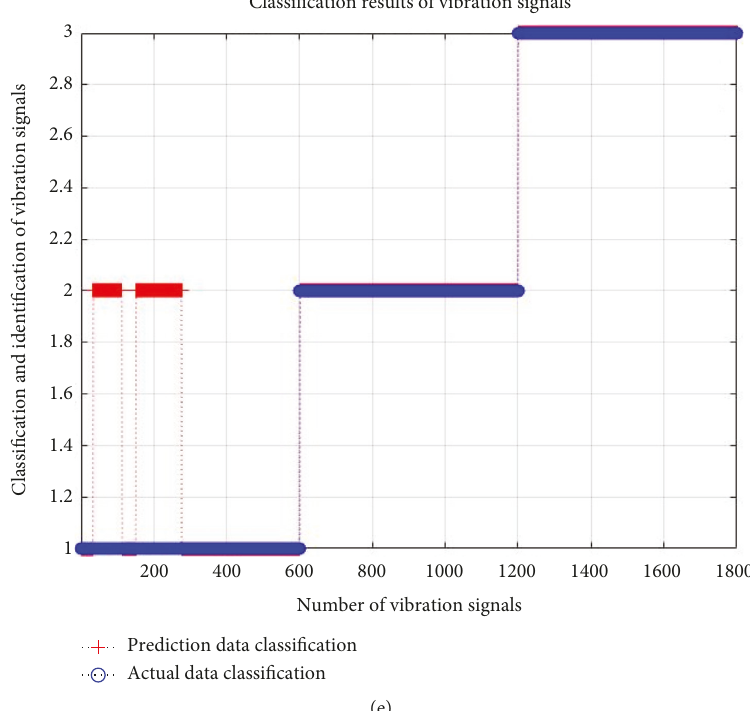
Figure 16: Identification rates of three units based on BP neural network. (a) Generator; (b) inlet; (c) middle of the spiral casing; (d) tail of the spiral casing; (e) outlet.